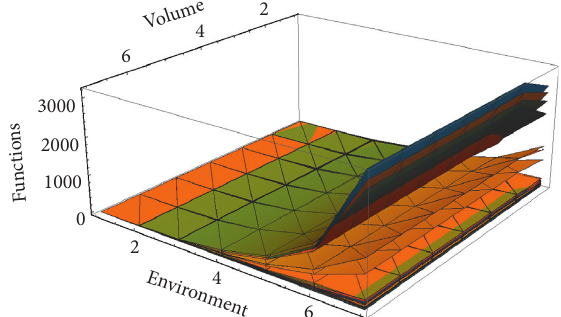
Figure 4: Number of functions as in Figure 2. Here we display only rules for which the number of functions for a fixed environment thickness increases from volume size 1 to volume size 2 and then remains constant for the rest of the volume sizes.